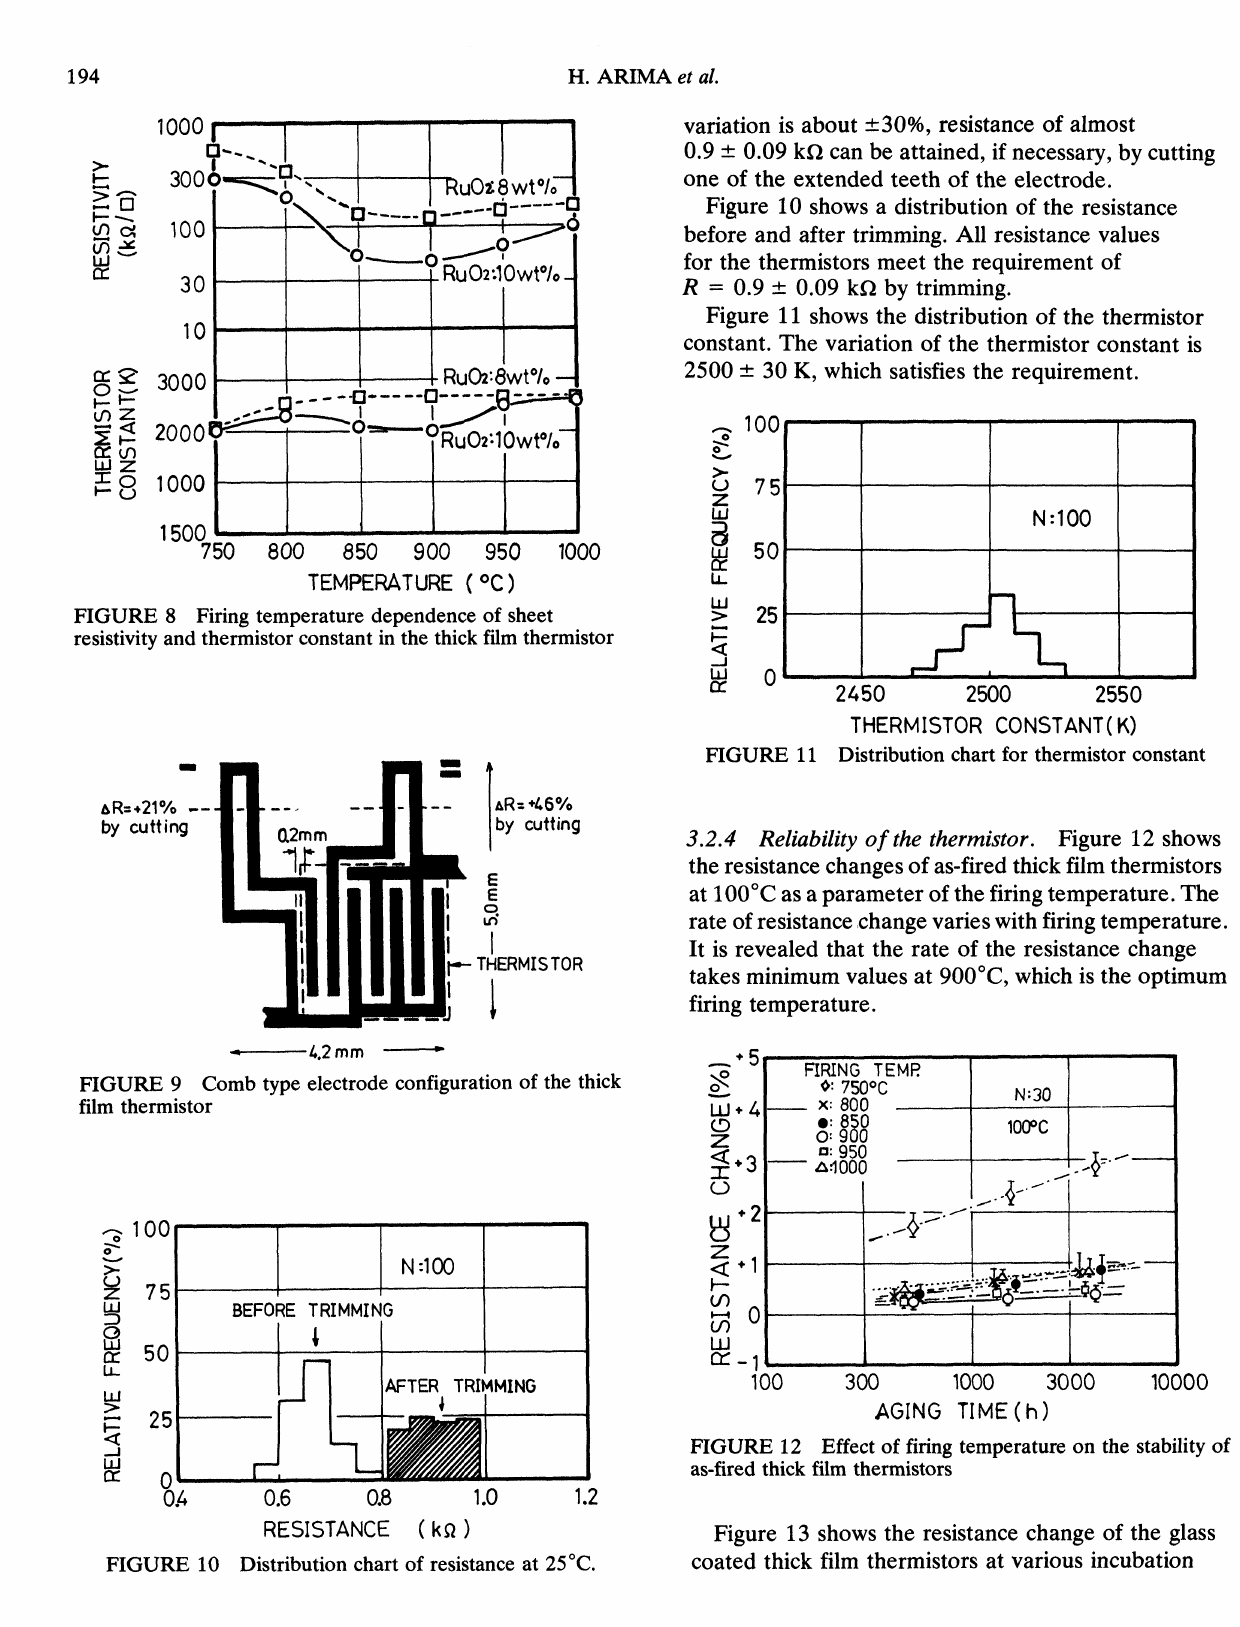
FIGURE 10 Distribution chart of resistance at 25C.